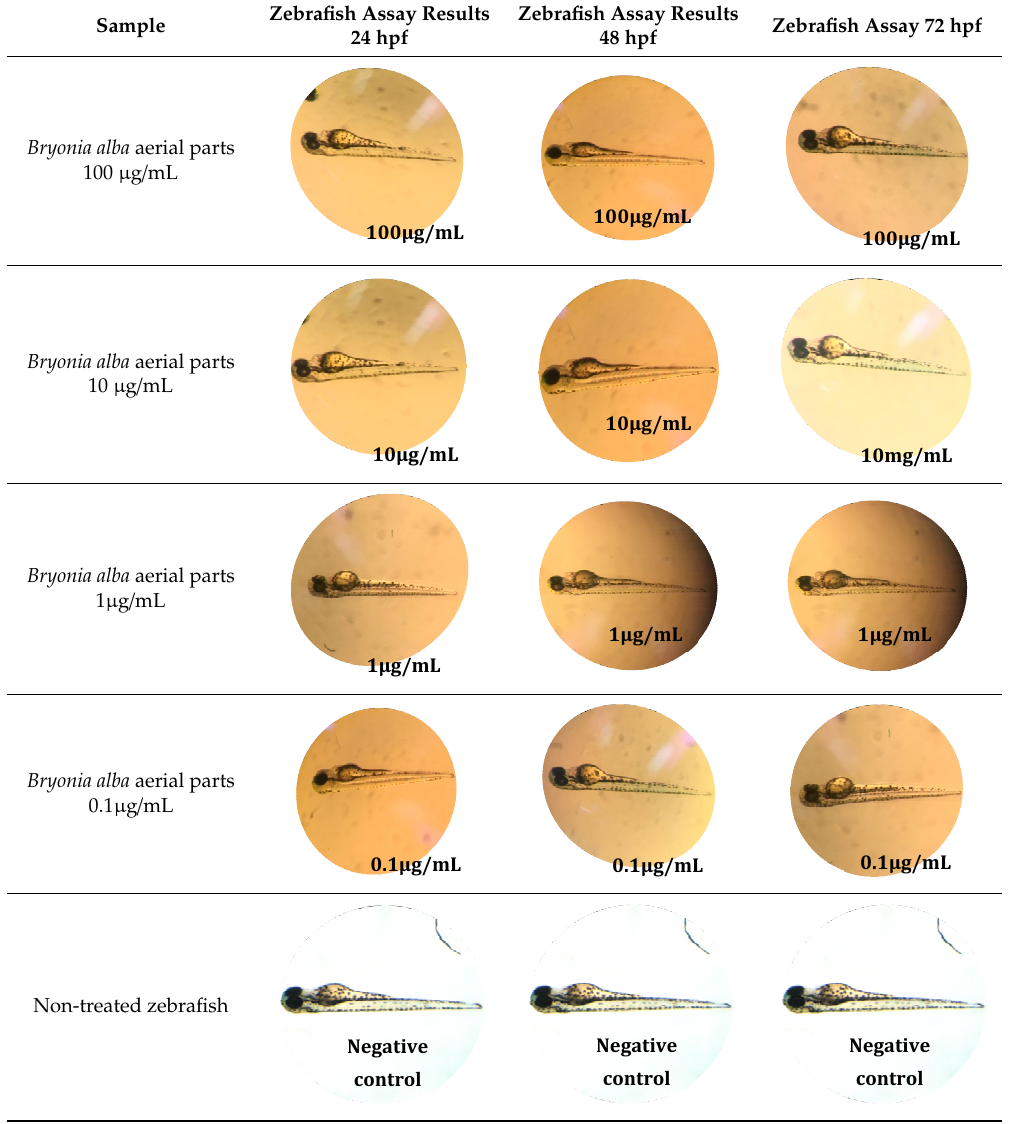
Table 5. Observation (40 × ) of zebrafish exposed to a concentration range of 0.1–100 µ g / mL of the aerial parts of Bryonia alba compared to the control at 24 hpf, 48 hpf, and 72